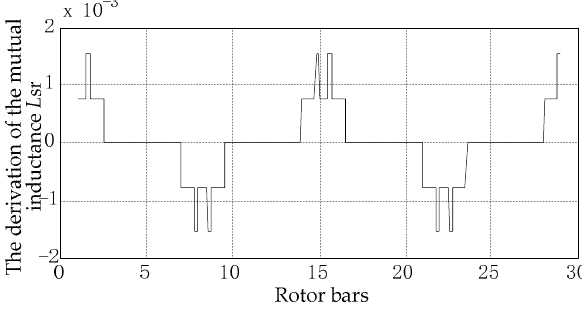
Figure 9. The derivation to the rotor position. Table 1. Mutual inductance and its derivation with respect to rotor position.